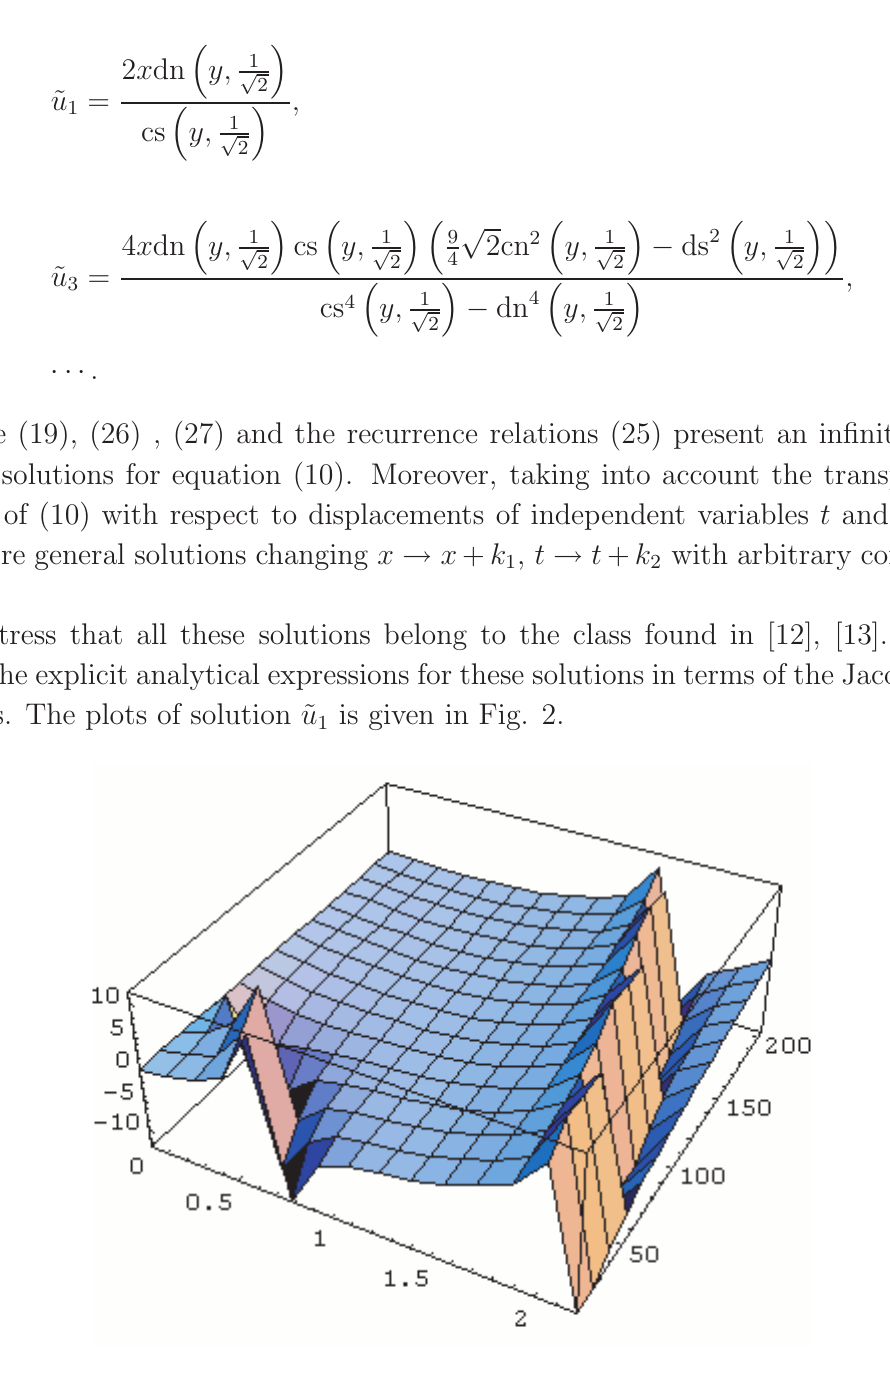
Fig. 2 Solution ˜ u 1 (27) for equation